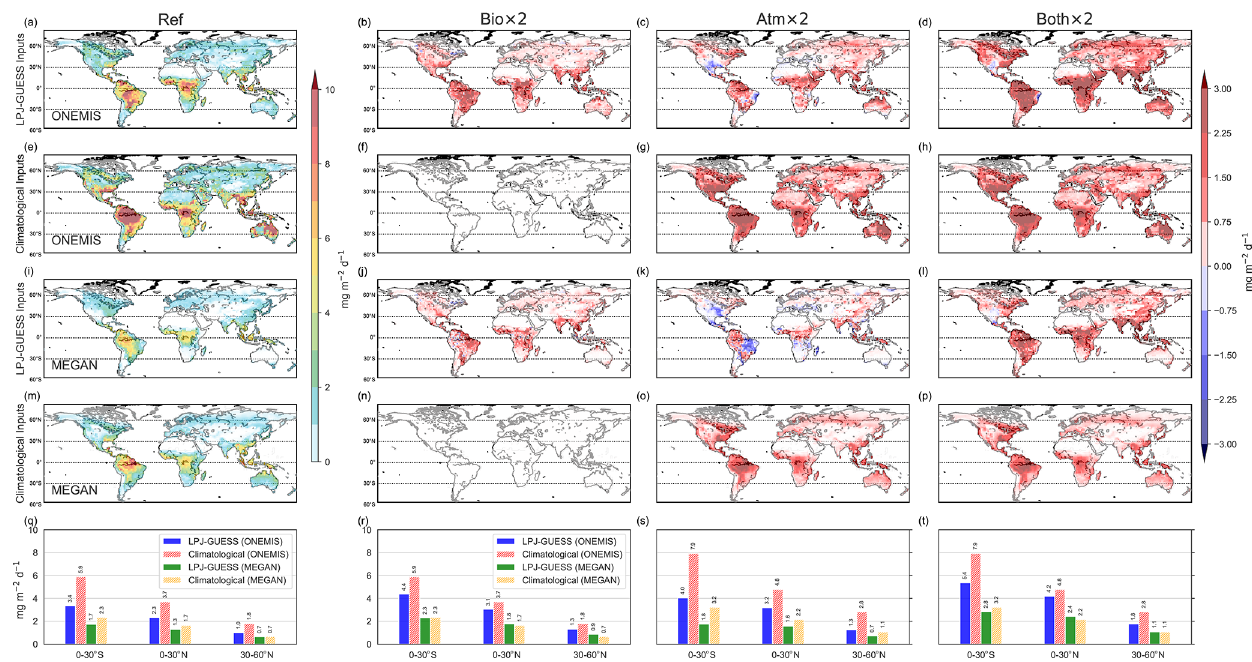
Figure 13. Same as Fig. 12 but for